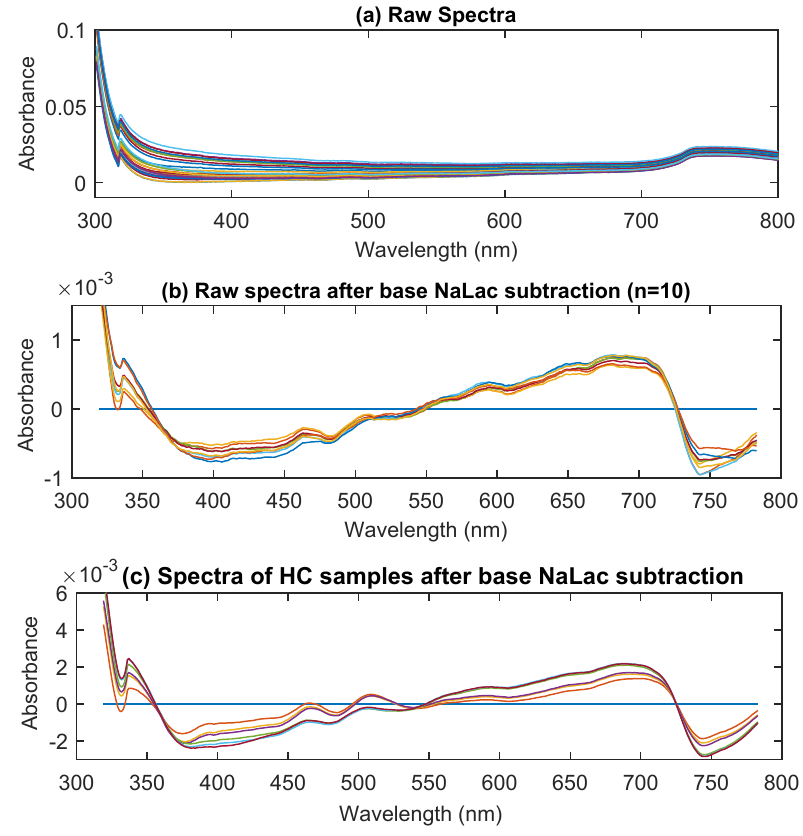
Figure 1. The ( a ) raw UV/Visible spectra of 37 samples with varying concentration of NaLac, ( b ) the raw spectra after base NaLac sample subtraction (0 mmol/l), and ( c ) base subtracted spectra of high concentration samples (100, 200, 300, 400, 500, and 600